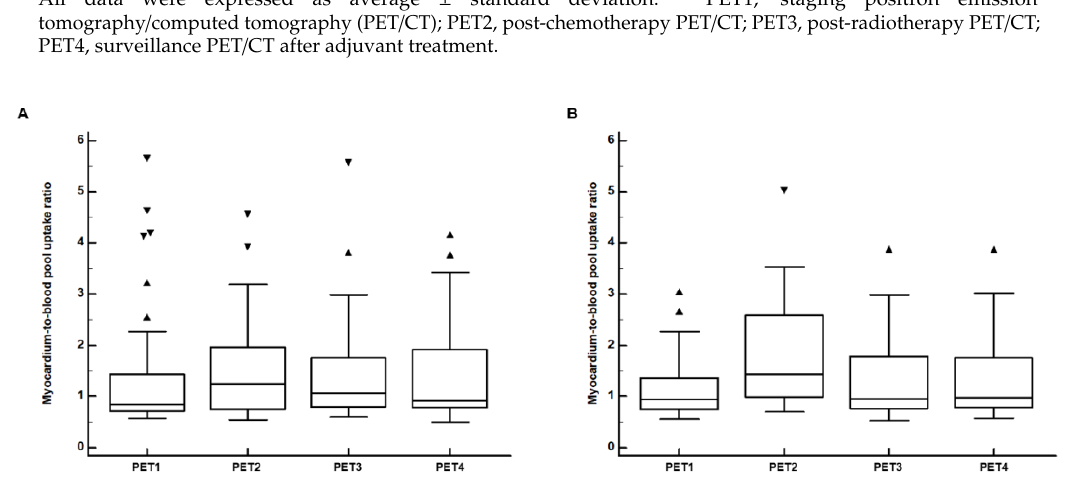
Figure 3. Distributions of the myocardium-to-blood pool uptake ratios on F-18 Fluorodeoxyglucose (FDG) positron emission tomography / computed tomography (PET / CT) for staging work-up (PET1), PET / CT after the completion of the adjuvant chemotherapy (PET2), PET / CT after the completion of the adjuvant radiotherapy (PET3), and follow-up PET / CT for surveillance (PET4) in ( A ) patients with left breast cancer and ( B ) patients with right breast cancer. (Central box, the values from the 25 percentile to 75 percentile; middle line in the box, median value; error bar, extending from the minimum value to the maximum value except outside values; marker, an outside value which is larger than the 75 percentile value plus 1.5 times the interquartile range).